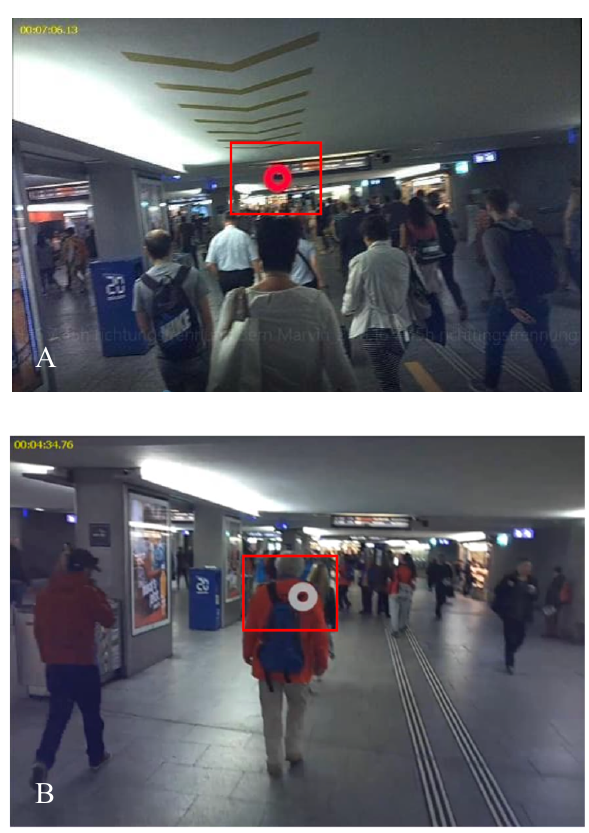
Figure 6. The departure information at the ceiling is fixated on by a majority of participants (A). Qualitative analyses of eye tracking data reveal that in the control and post intervention conditions overall attention is directed towards other pedestrians who are in front of the test participants